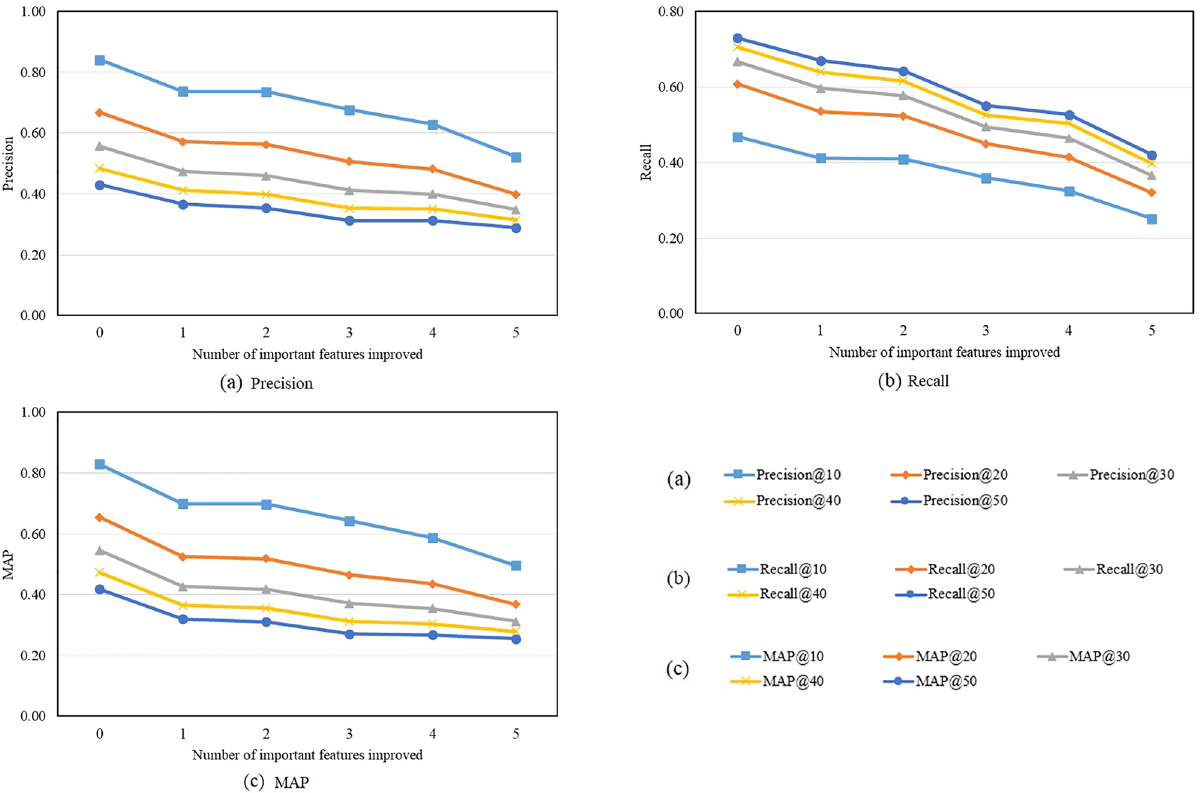
Figure 5. Recommendation performance after removing important